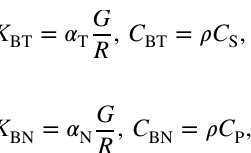
Fig. 4 Three-dimensional finite element model of the track−formation system: a general view; b cross section